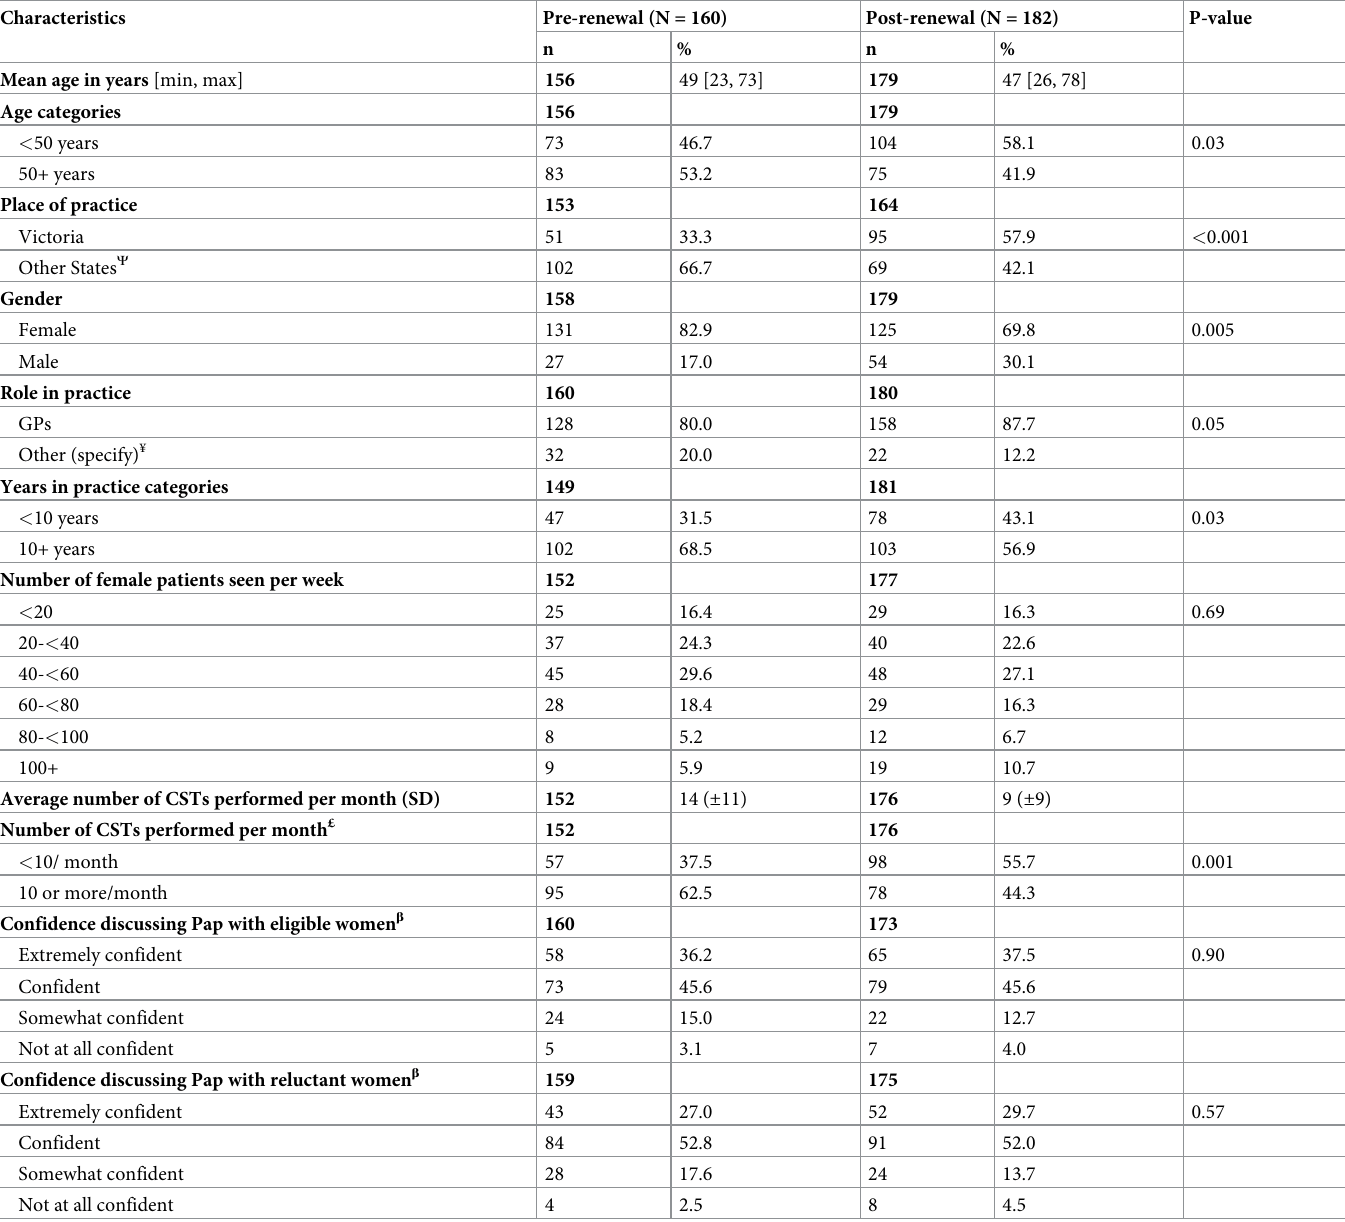
Table 2. Characteristics of 342 Australian primary care practitioners recruited in the pre and post-renewal periods of the cervical screening program � .